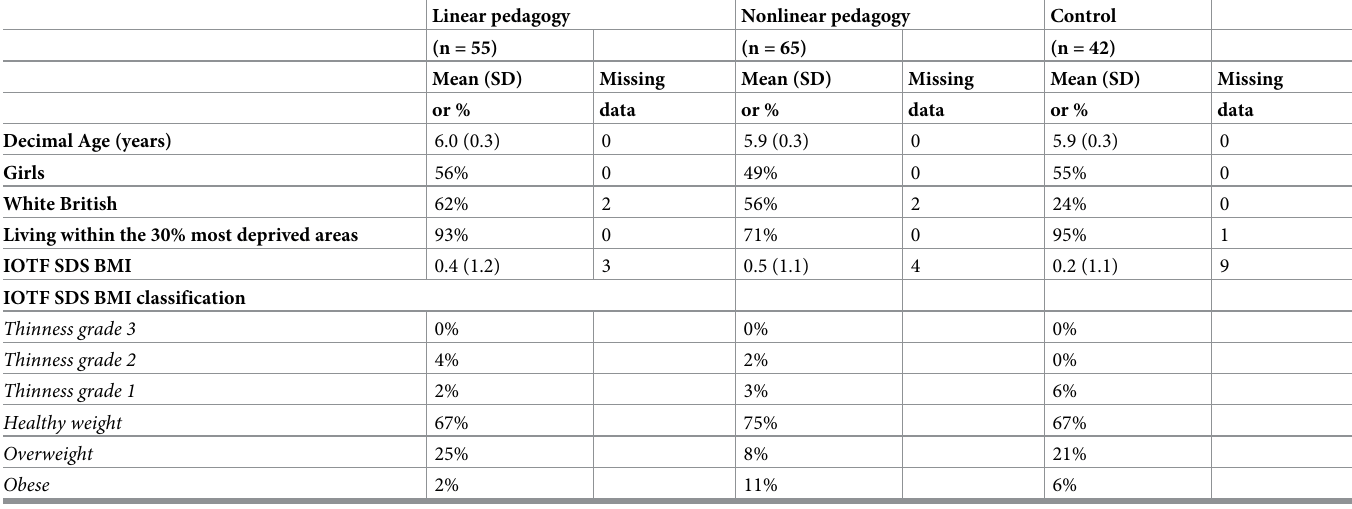
Table 1. Participants’ descriptive data by group.